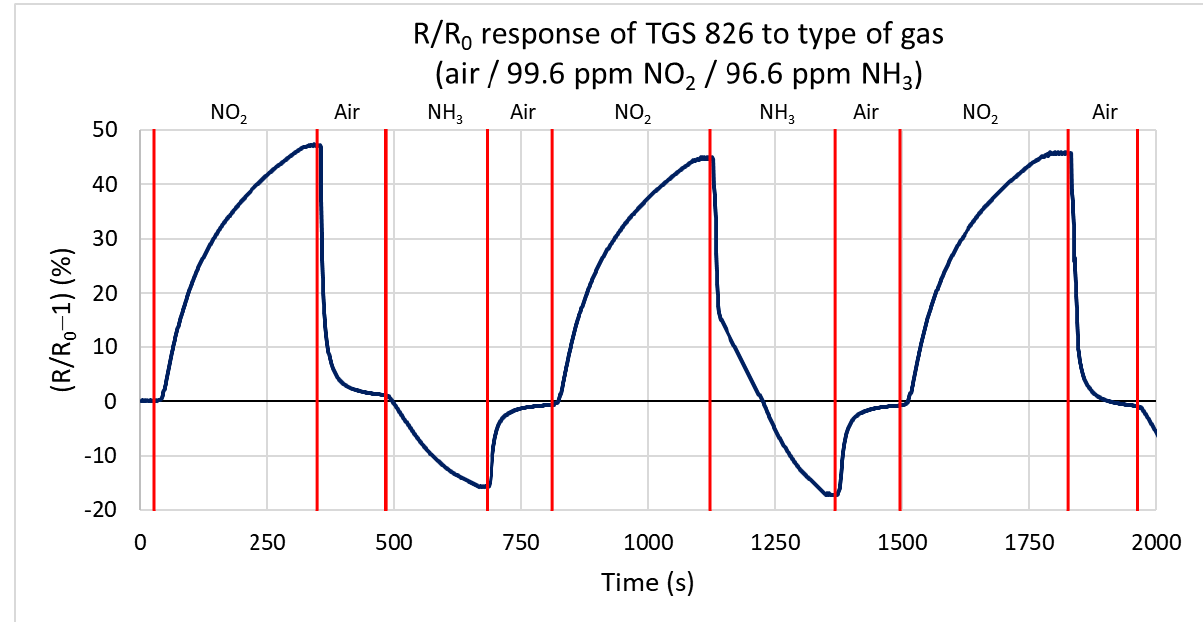
Figure 12. Response of TGS 826 sensor to three types of gases (ammonia, nitrogen dioxide, and synthetic air) at a gas flow rate of 100 sccm.